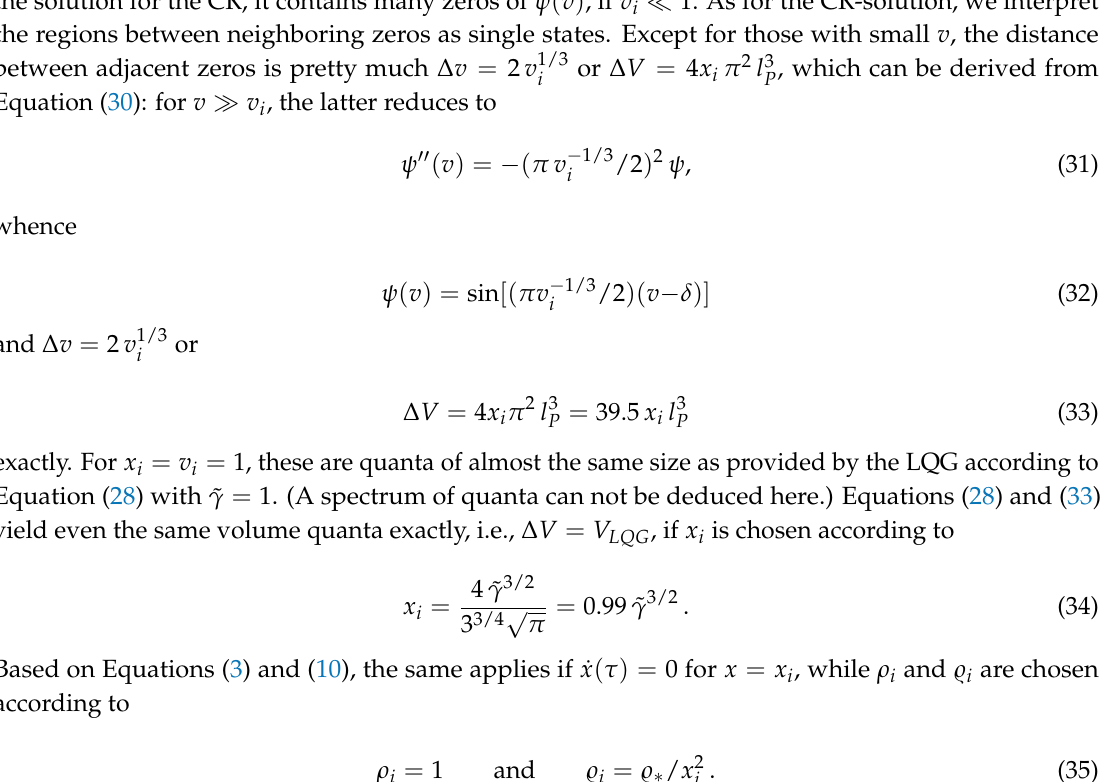
Figure 5. QR-solution of Equation (30) with v i 1. For the reason of presentability, only a small value, v i = 10 − 4.5 , was used. The short horizontal (cid:29) line at the top right is the beginning of ψ 2 c ( v )